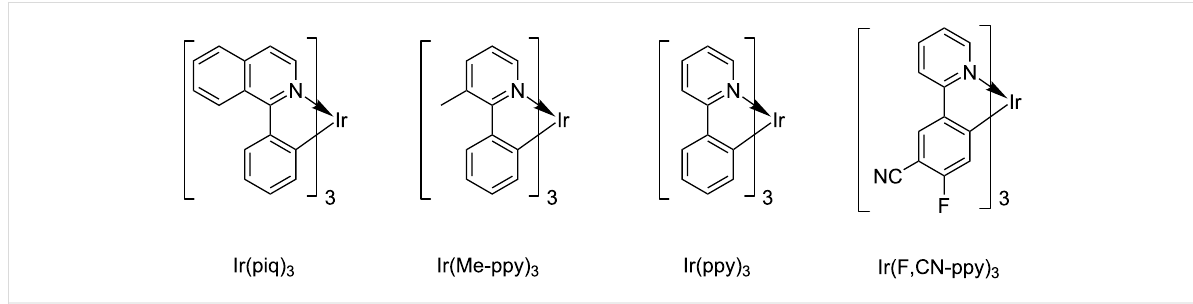
Figure 1: Structures of the investigated phosphorescent triscyclometalated iridium